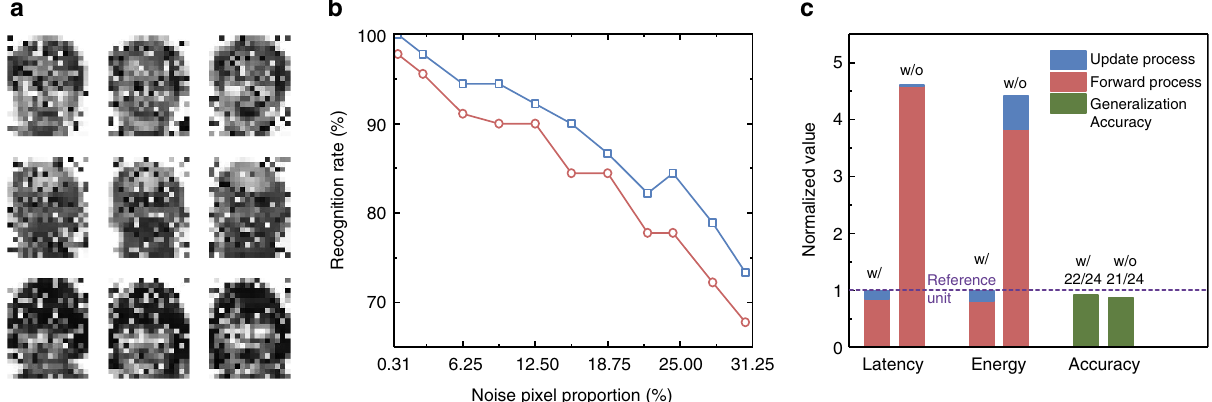
Figure 5 | The test result with latency and energy comparison. ( a ) A standard example of the constructed test patterns with 100 noise pixels with respect to each training image in Fig. 2c. ( b ) The recognition rate curve of two programming strategies during the test. The x axis represents the amount of noise. ( c ) The comparison between with (W/) and without (W/O) schemes in terms of latency and energy consumption during training process and testing recognition rate in the normalized compared with the 91.48% recognition rate by standard method.